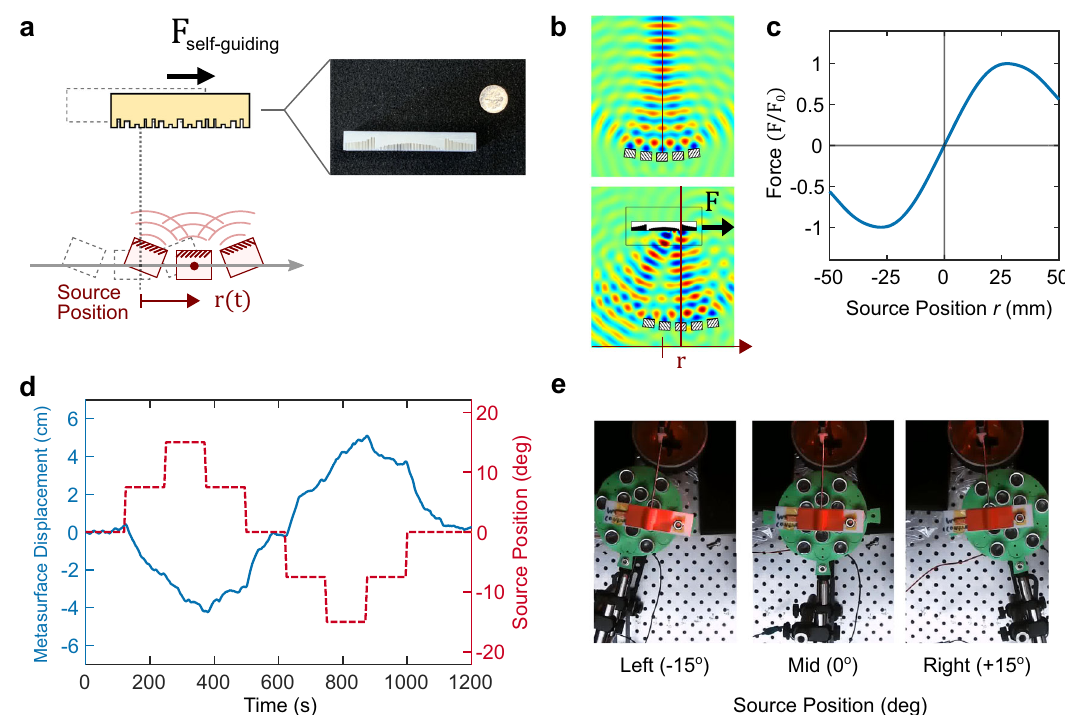
Fig. 3 | Metasurface self-guiding: concept and demonstration. a Metasurface is designed to autonomously track and guide itself to follow the movement of the radiation source. Right: fabricated metasurface (a dime is shown for scale). b Top: Focused acoustic intensity pro fi le emanating from a set of piezoelectric transdu- cers that comprise the source of radiation (20kHz). The solid line denotes the radiationaxis.Bottom:Scatteringmapforacasewhenthemetasurfaceisdisplaced